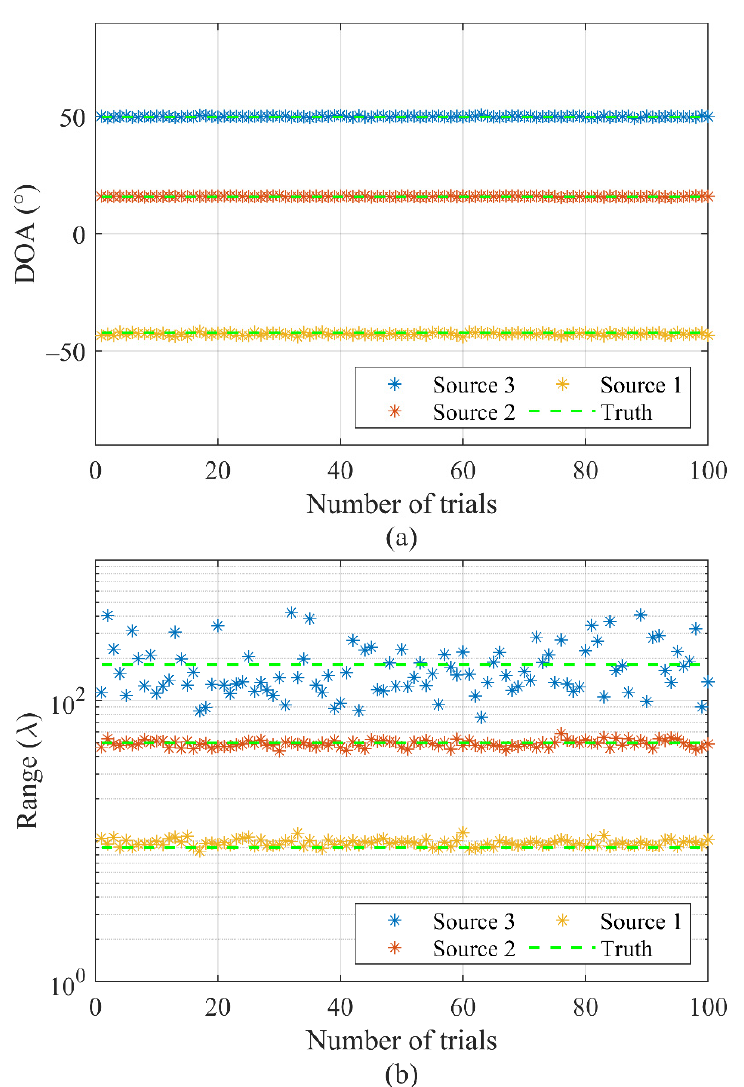
Figure 7. Localization for two near-field sources and one far-field source of 100 independent trials by the CVMD-based method: ( a ) DOA estimation. ( b ) Range estimation.